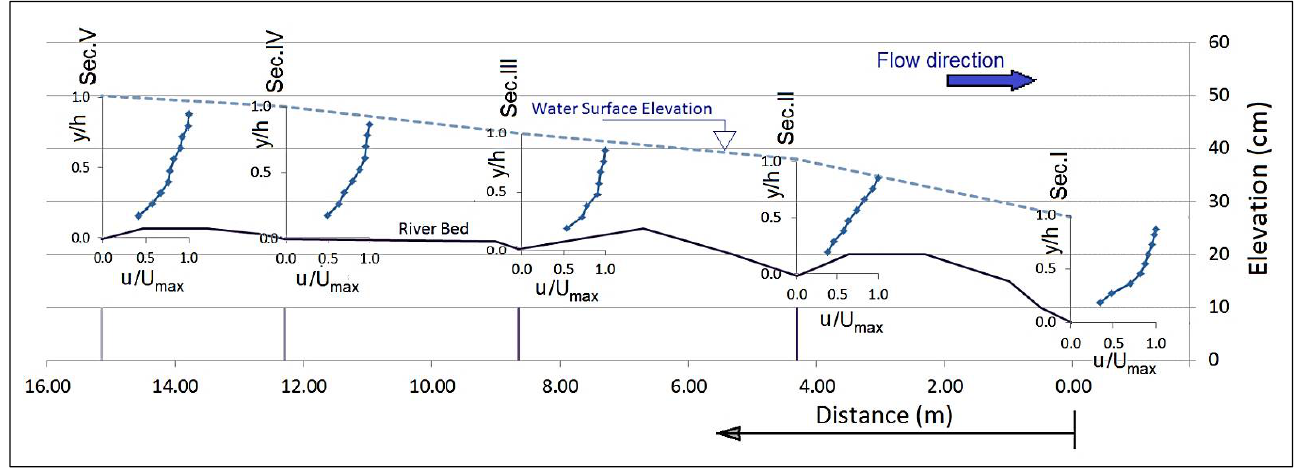
Figure 6. Water surface elevation (light blue dashed line), riverbed elevation (violet line), and velocity profiles (dark blue lines) along the center of mass’ line (centroid line)—selected reach of Marbor River. Table 3. Measured and calculated flow parameters in the Marbor